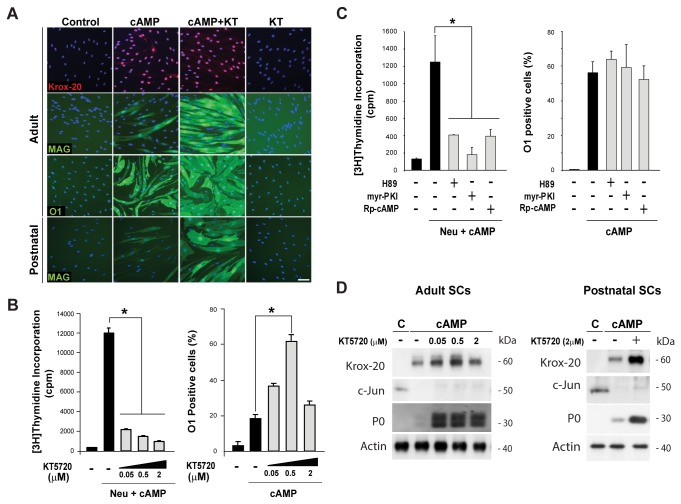
Non-antagonistic effect of PKA inhibitors on the cAMP-induced differentiation of isolated SCs.SC-only cultures were stimulated with CPT-cAMP (250 µM) provided alone (A-D) or in combination with 10 nM neuregulin (B-C) in the absence (control) or presence of PKA inhibitors (as indicated) for 3 days. Cells were evaluated for the expression of the indicated markers of differentiation by immunofluorescence microscopy (A-C) and western blot (D). In parallel, cultures were analyzed for the incorporation of [3H]-thymidine (B-C, left panels). In A and D, results were validated using cultures of postnatal rat SCs, as indicated. Inhibitors were used at the concentrations indicated in the figure or as follows: H89 (1 µM), KT5720 (1 µM), myr-PKI (40 µM), and Rp-cAMP (200 µM).